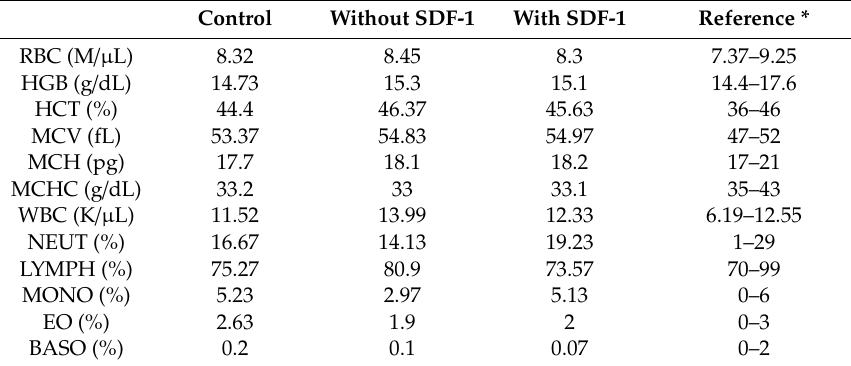
Table 3. Whole blood test (one month).